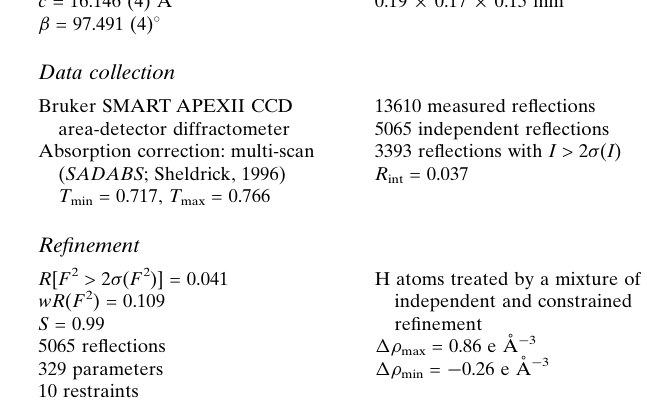
Bruker SMART APEXII CCD area-detector diffractometer